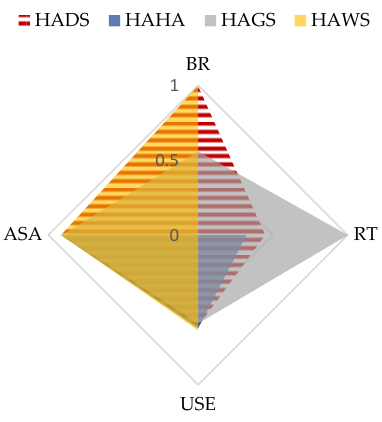
Figure 18. The radar chart of data set 1 when N a =